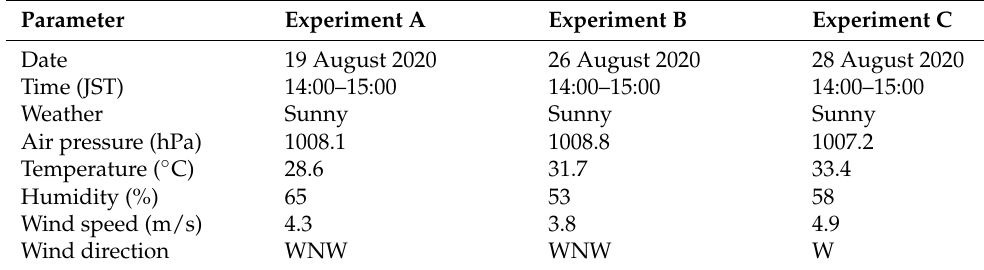
Table 5. Meteorological conditions on the respective experiment days.